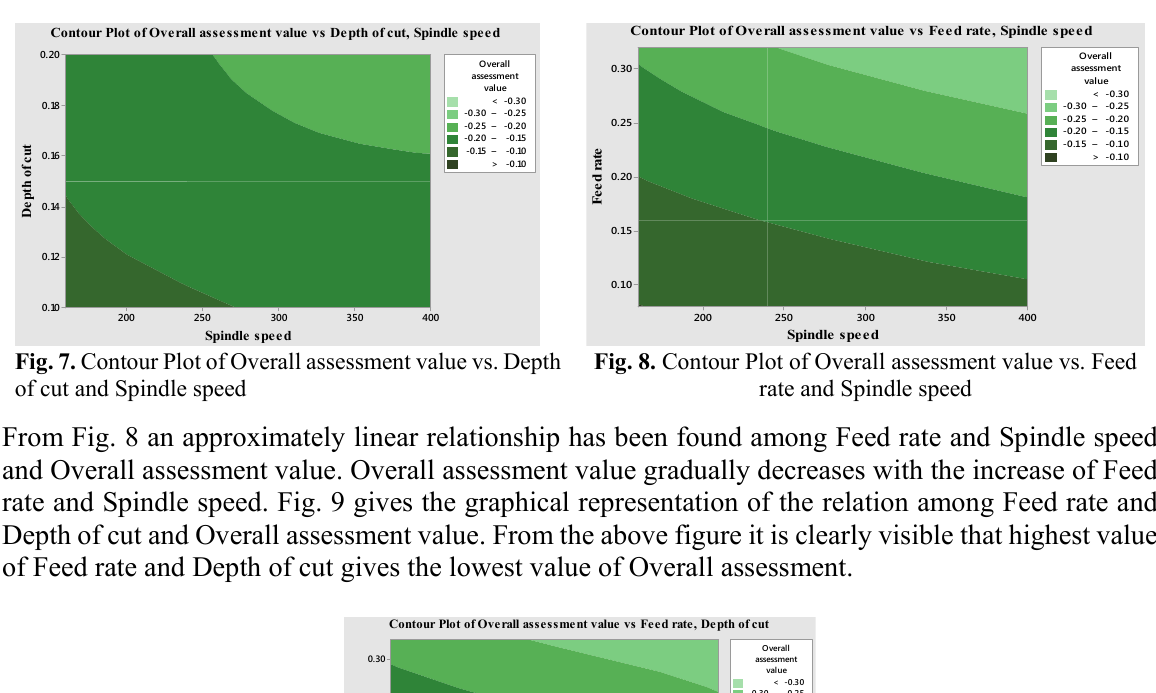
Contour Plot of Overall assessment value vs Feed rate, Depth of